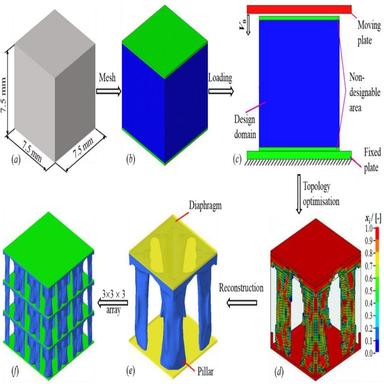
The process of topology optimisation and material construction: (a) the initial cubic cell; (b) the meshed cubic model; (c) the loading condition of the FE model; (d) the distribution of relative density in the topology-optimised cell; (e) the reconstructed lattice cell; (f) a 3 × 3 × 3 lattice material with 27 unit cells.